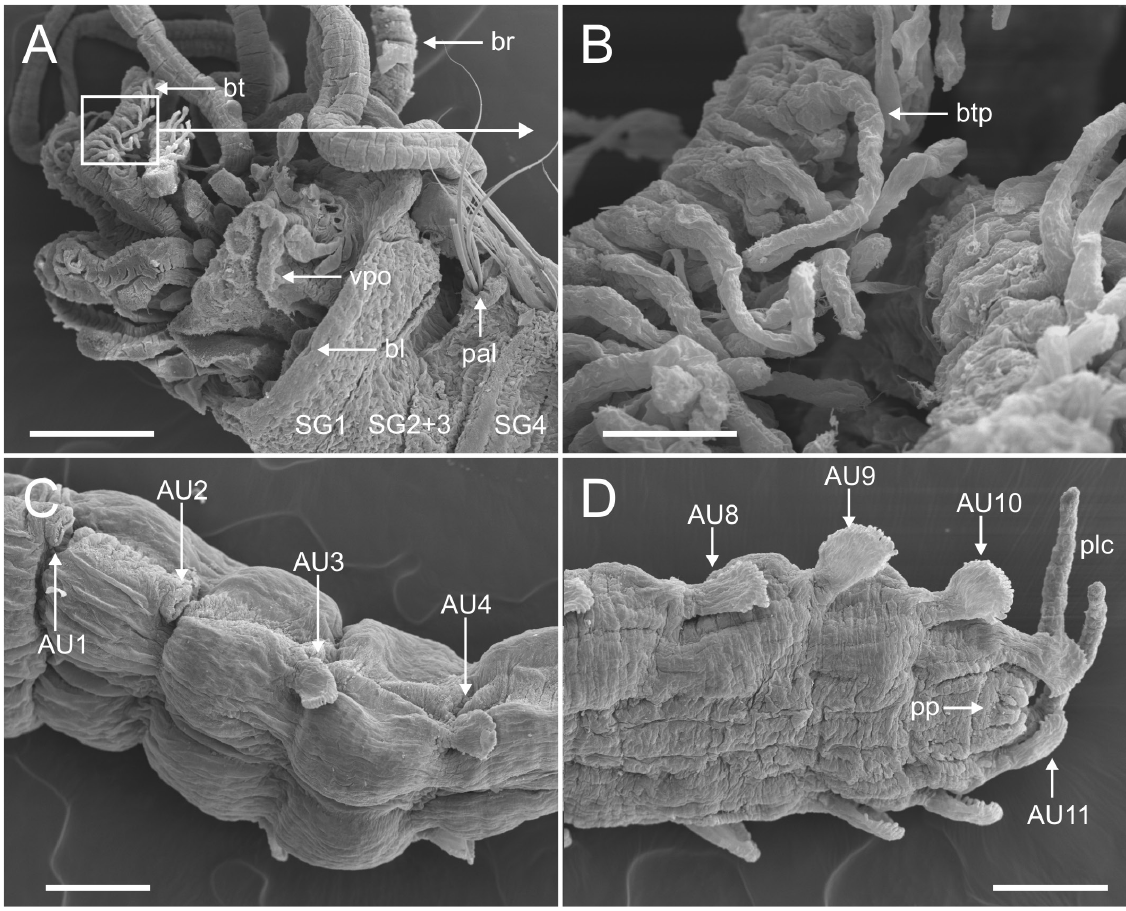
Fig. 7. Ampharete oculicirrata sp. nov., paratype MNCN 16.01/18482_spec. 5. A . Anterior end, ventral view. B . Buccal tentacle with pinnae. C . First four abdominal uncinigers, lateroventral view. D . Posterior end, from AU8 to pygidium, ventral view. Abbreviations: AU = abdominal unciniger; bl = buccal lip; br = branchia; bt = buccal tentacle; btp = buccal tentacle pinna; pal = paleae; plc = pygidial lateral cirrus; pp = pygidial papillae; SG = segment; vpo = ventral pharyngeal organ. Scale bars: A, C = 150 µm; B = 25 µm; D = 100